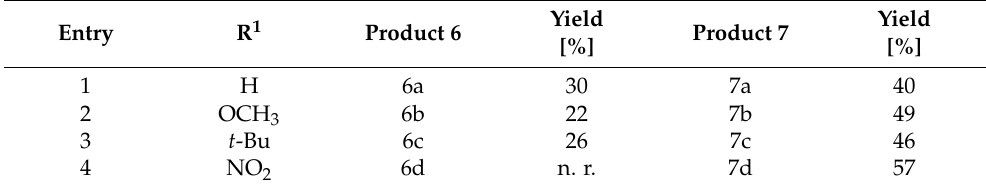
Table 1. The yield of the reaction for the preparation of imidoyl chlorides ( 6a – d ) and 1,3,4-oxadiazoles ( 7a – d ).